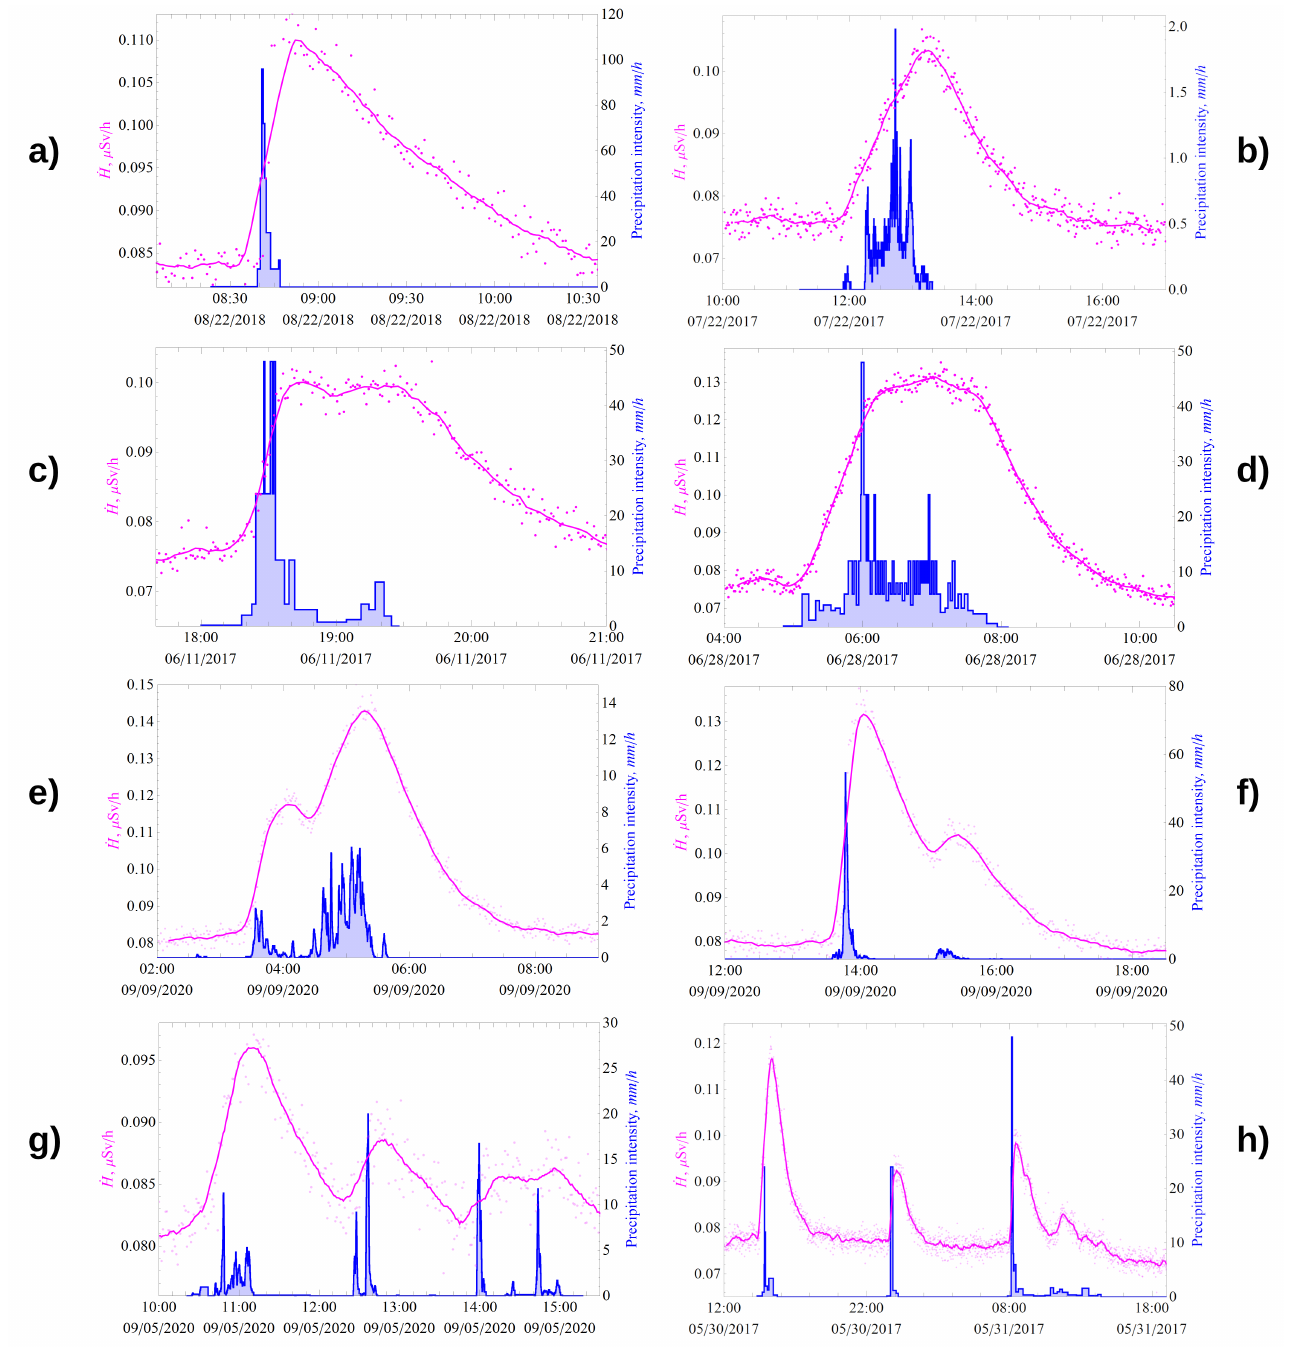
Figure 1. Different forms of γ -background responses to liquid atmospheric precipitation (occurred at IMCES, Tomsk, RF): ( a ) peak with left position of maximum; ( b ) middle maximum position; ( c ) flat/plateau shaped; ( d ) bell-shaped; ( e , f ) double- humped shape; ( g ) wave-shaped; ( h ) toothed